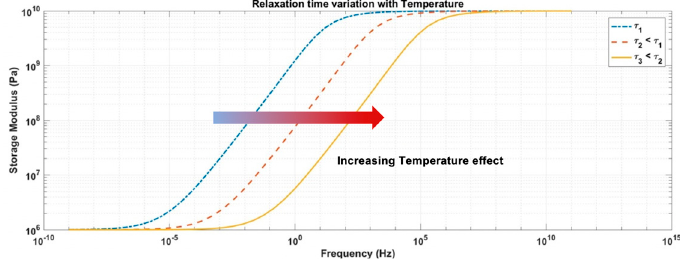
Figure 16. H-N model. Relaxation Time dependence on Temperature.